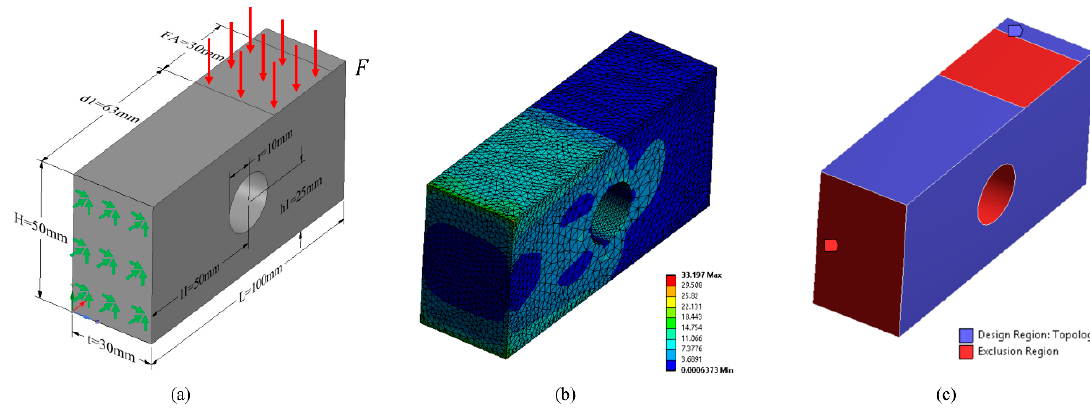
Figure 8. ( a ) The original design of the Hollow Plate, as well as the finite element model, ( b ) the Finite Element Analysis (FEA) of the Hollow Plate ( σ max = 33.2 MPa), and c) the design space for the Topology Optimization (TO).